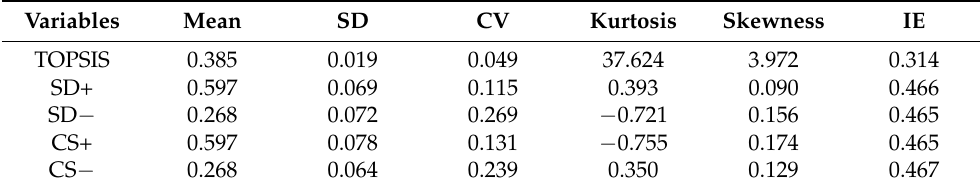
Table 3. Descriptive statistics for alternative performance